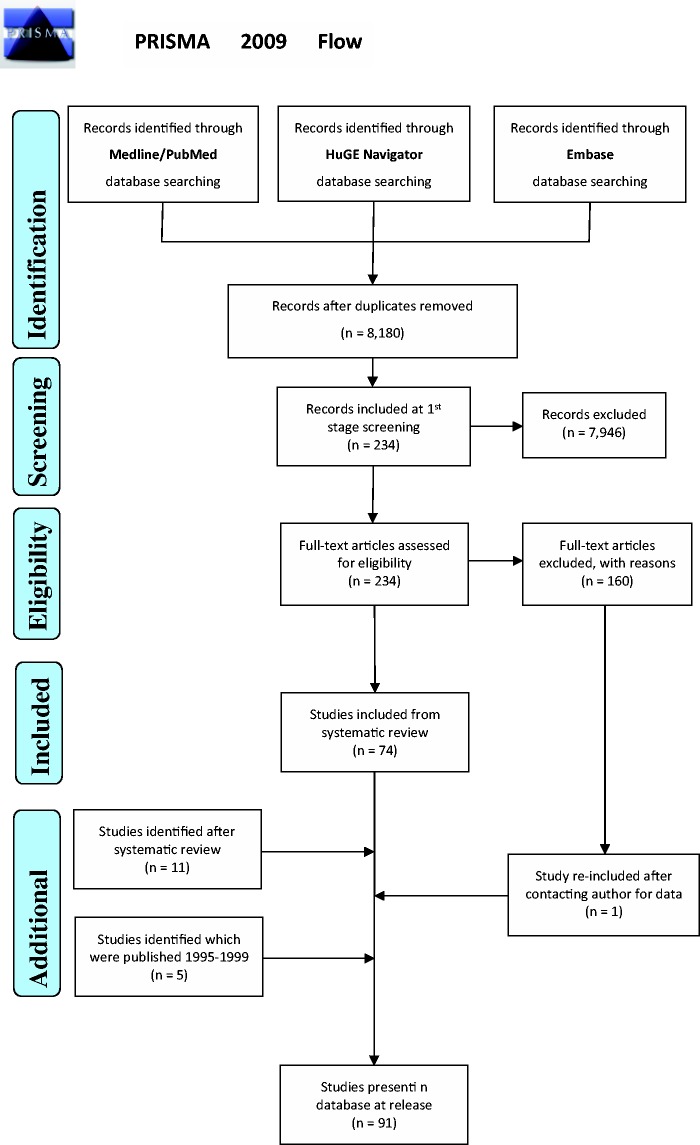
PRISMA 2009 Flow demonstrating the procedures followed for including data sets in
HLA-ADR.